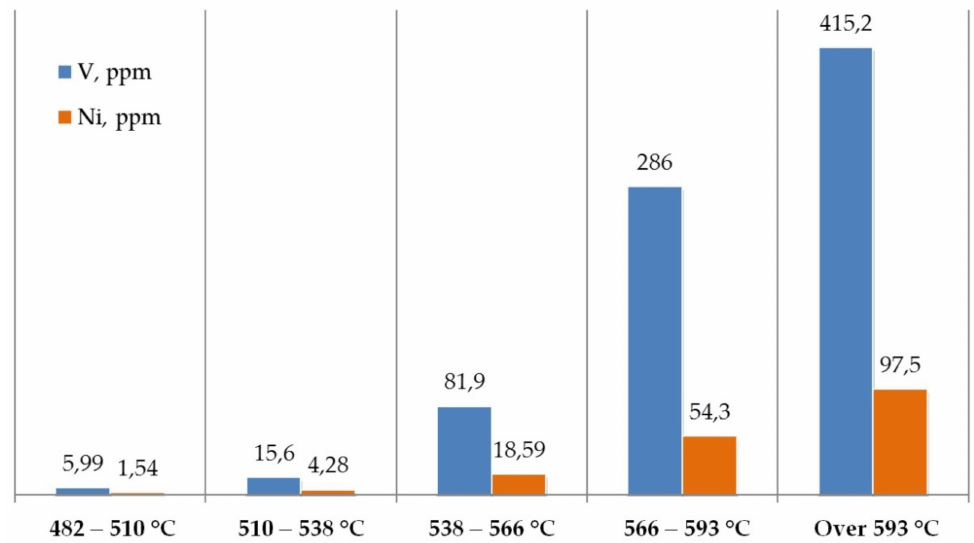
Figure 1. Ni and V fractional distribution of heavy North American